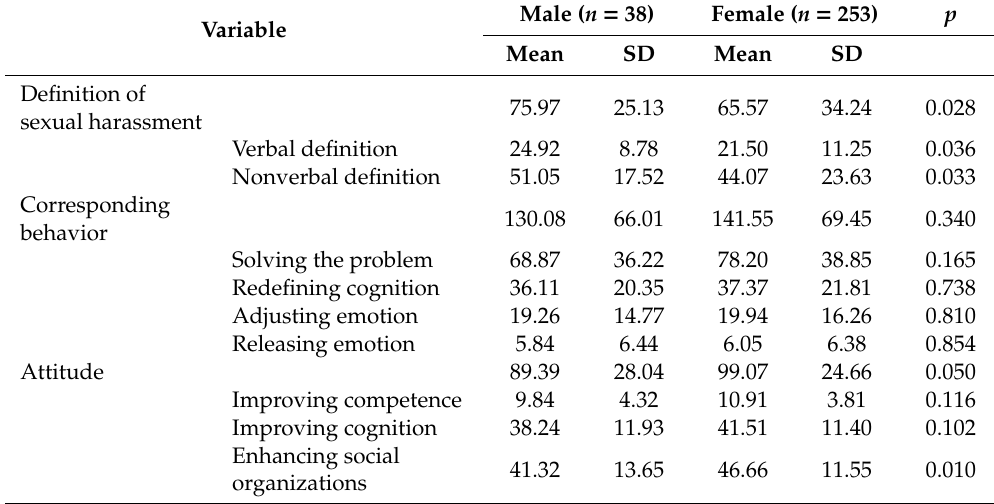
Table 3. Participants’ scores for sexual harassment knowledge, coping behaviors, and attitude.